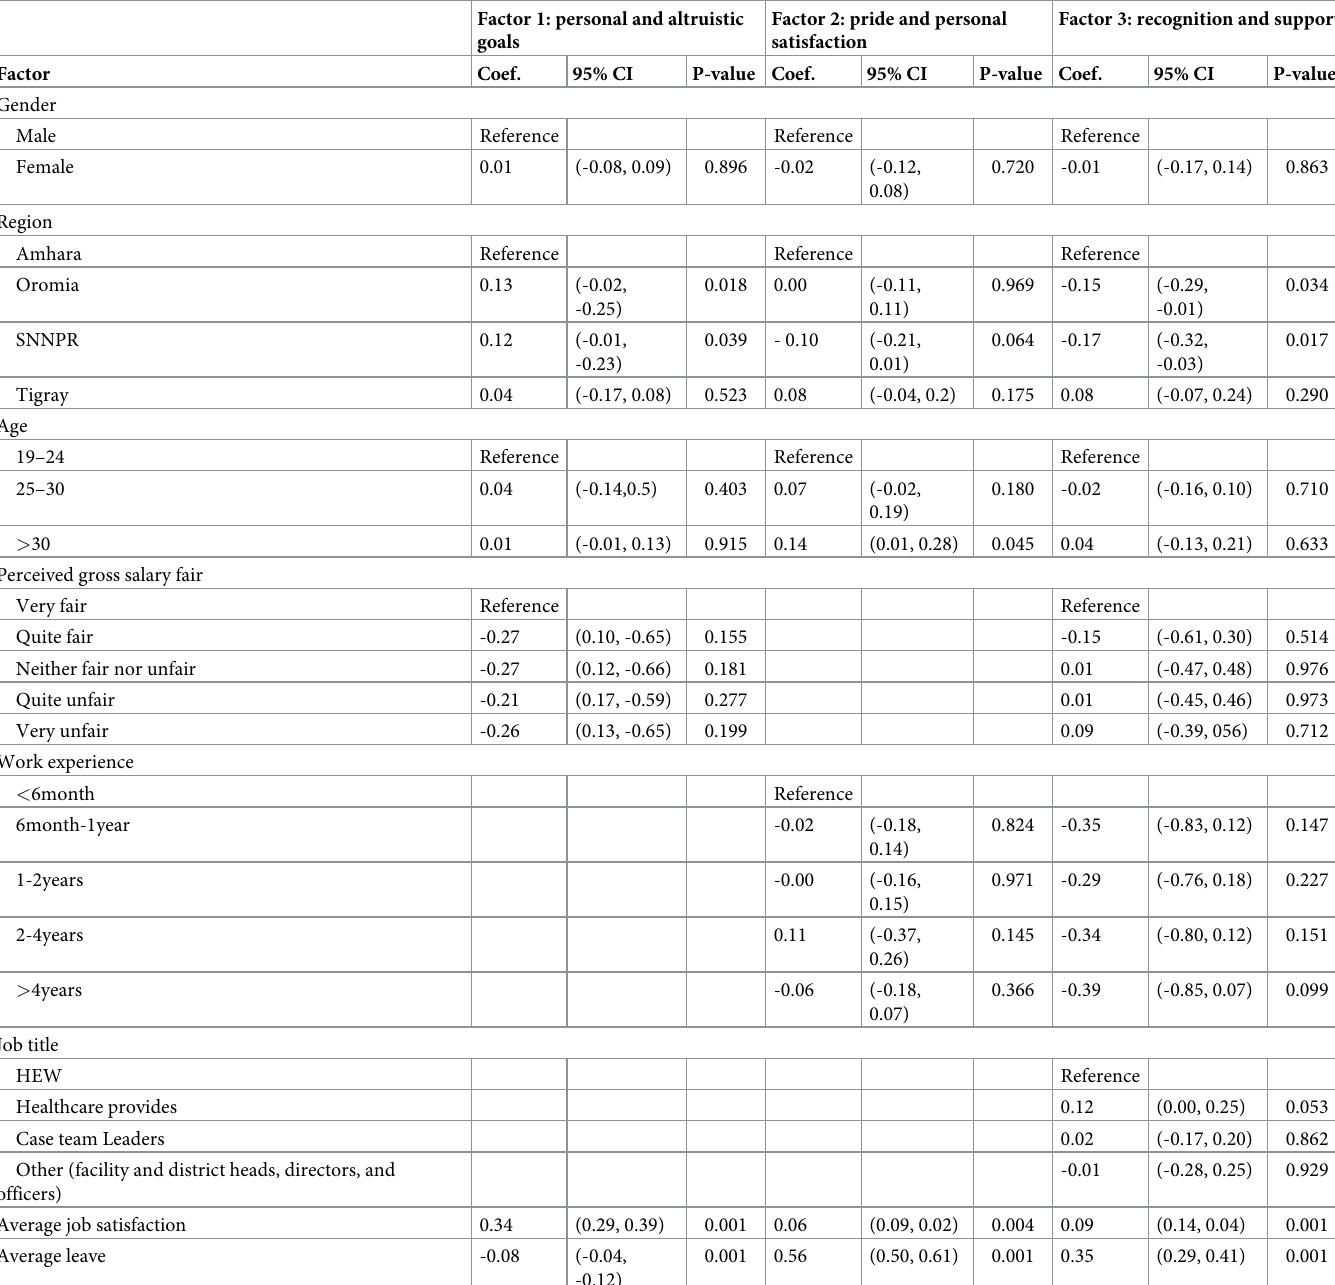
Table 5. Association between motivation factors and demographic and structural factors among participants from four regions April 15–May 10, 2018.